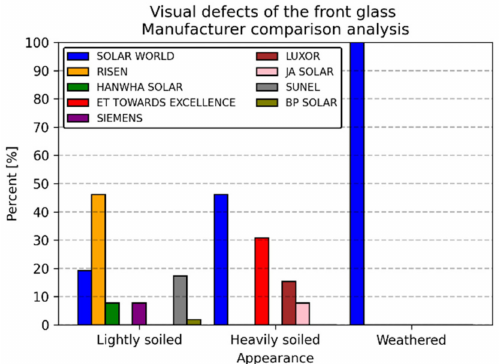
Figure 7. Manufacturer comparison of front glass